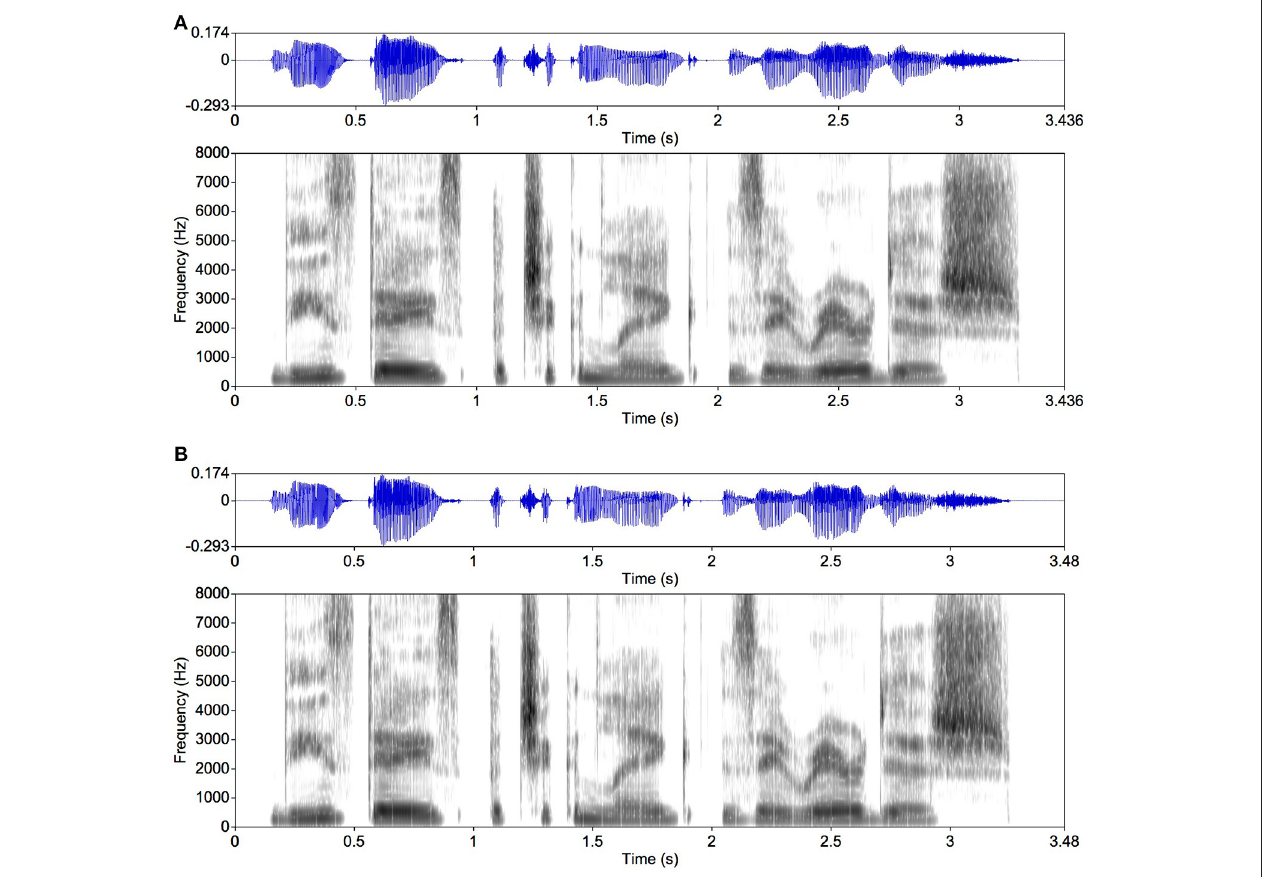
FIGURE 2 | An example of original speech. Speech waveforms and spectrograms are presented. The sound energy distribution in each spectrogram is indicated by the gray density (the darker the gray, the higher the sound-energy density). (A) An English sentence (for illustration) as original speech spoken by a female native speaker, saying “These days a chicken leg is a rare dish.” (B) The original speech divided into 80-ms segments smoothed with 5-ms rise and fall times. The white vertical lines in the spectrogram in (B) are the rise and fall times that delimit the speech segments. No such vertical lines are observed in the spectrogram in (A) . The original speech data were taken from the NTT-AT Multi-Lingual Speech Database 2002. Figures 2 – 4 were made with Praat (Boersma and Weenink, 2016).